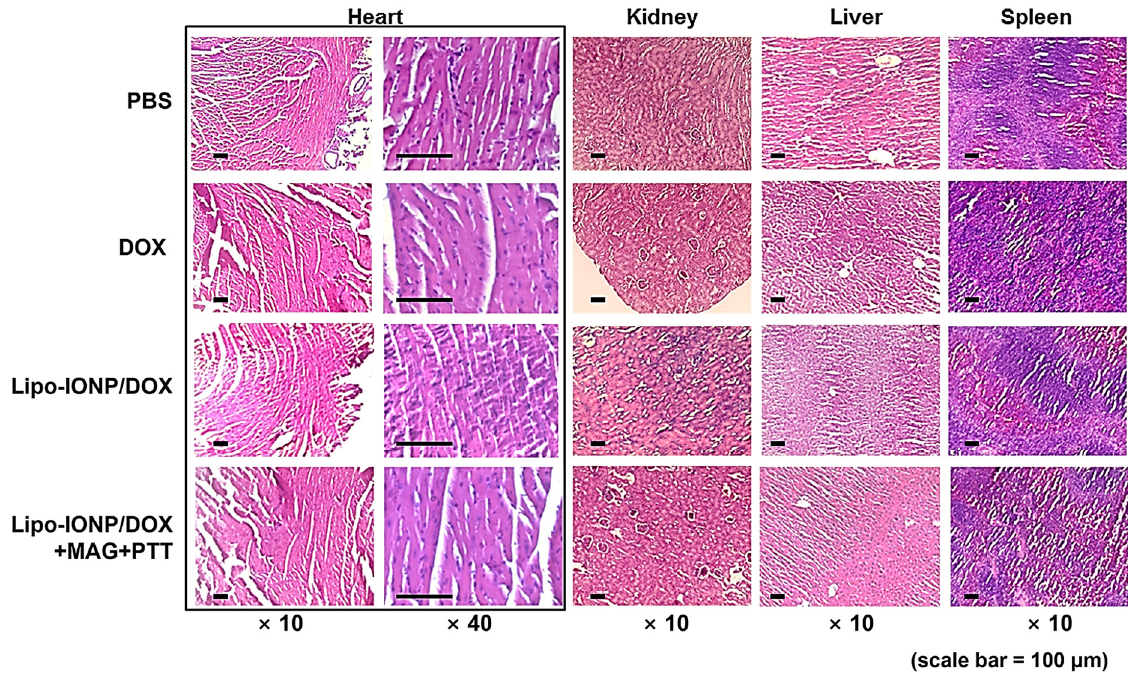
Figure 10. Histological analysis of the major organs after the efficacy study. The images showed no apparent toxicity from any of the major organs of all the experimental groups. Heart, kidney, liver, and spleen tissues were removed from the mice of each group and stained by H&E: mice groups are (1) PBS-control, (2) DOX (4 mg/kg), (3) Lipo-IONP/DOX (24 mgFe/kg as Lipo-IONP; 4 mg/kg as DOX), (4) Lipo-IONP/DOX+MAG+PTT (24 mgFe/kg as Lipo-IONP; 4 mg/kg as DOX). For the Lipo-IONP/DOX+MAG+PTT group, the mice were administered with Lipo-IONP/DOX and then followed by magnetic targeting and photothermal treatment (Lipo-IONP/DOX: doxorubicin-loaded liposomal iron oxide nanoparticle).